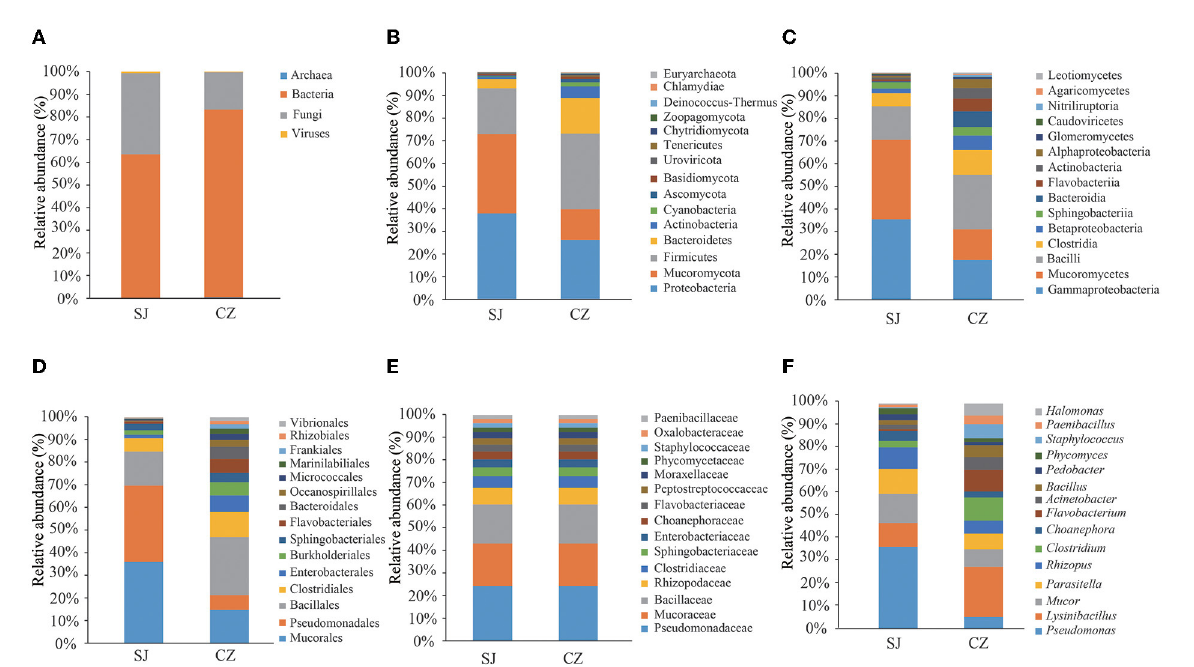
FIGURE1 Taxonomic analyses at the levels of Kingdom (A) , Phyla (B) , Classes (C) , Orders (D) , Families (E) , and Genera (F) of Anser erythropus wintering at Shengjin (SJ) and Caizi (CZ) Lakes.